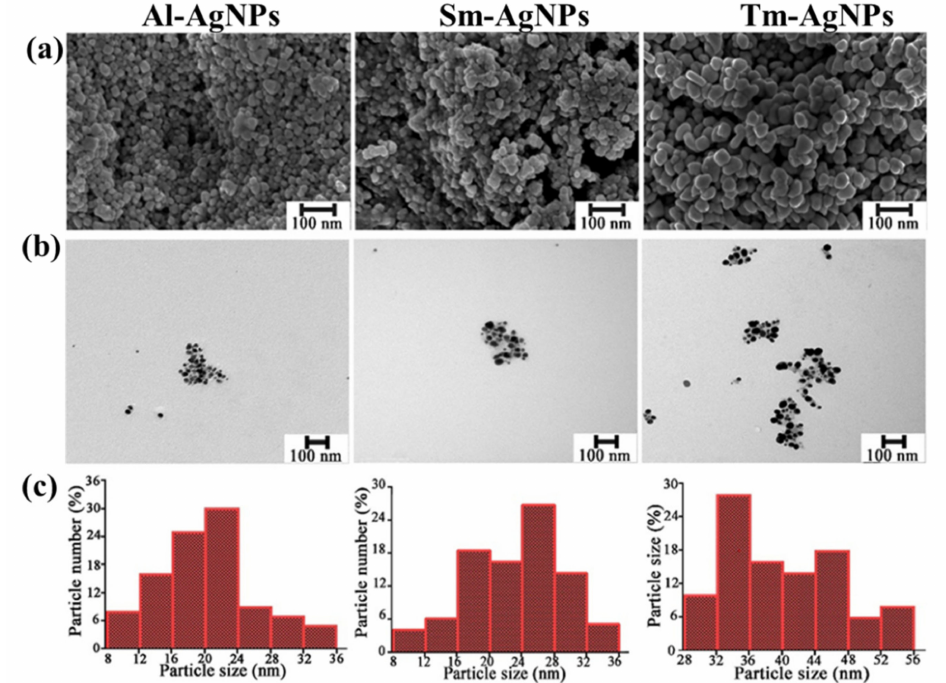
Figure 3. Morphology and size of Al-AgNPs, Sm-AgNPs, and Tm-AgNPs, scale bar = 100 nm. ( a ) SEM image ( b ) TEM image. ( c ) Size distribution of